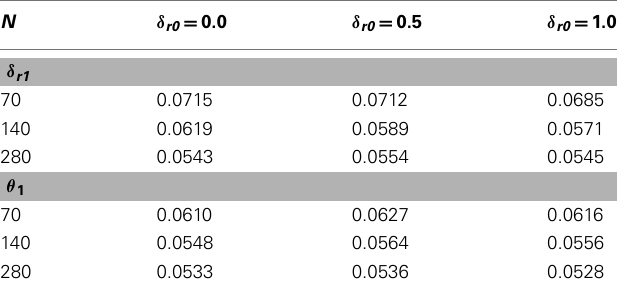
Table 6 | Unmoderated continuous moderator simulations.